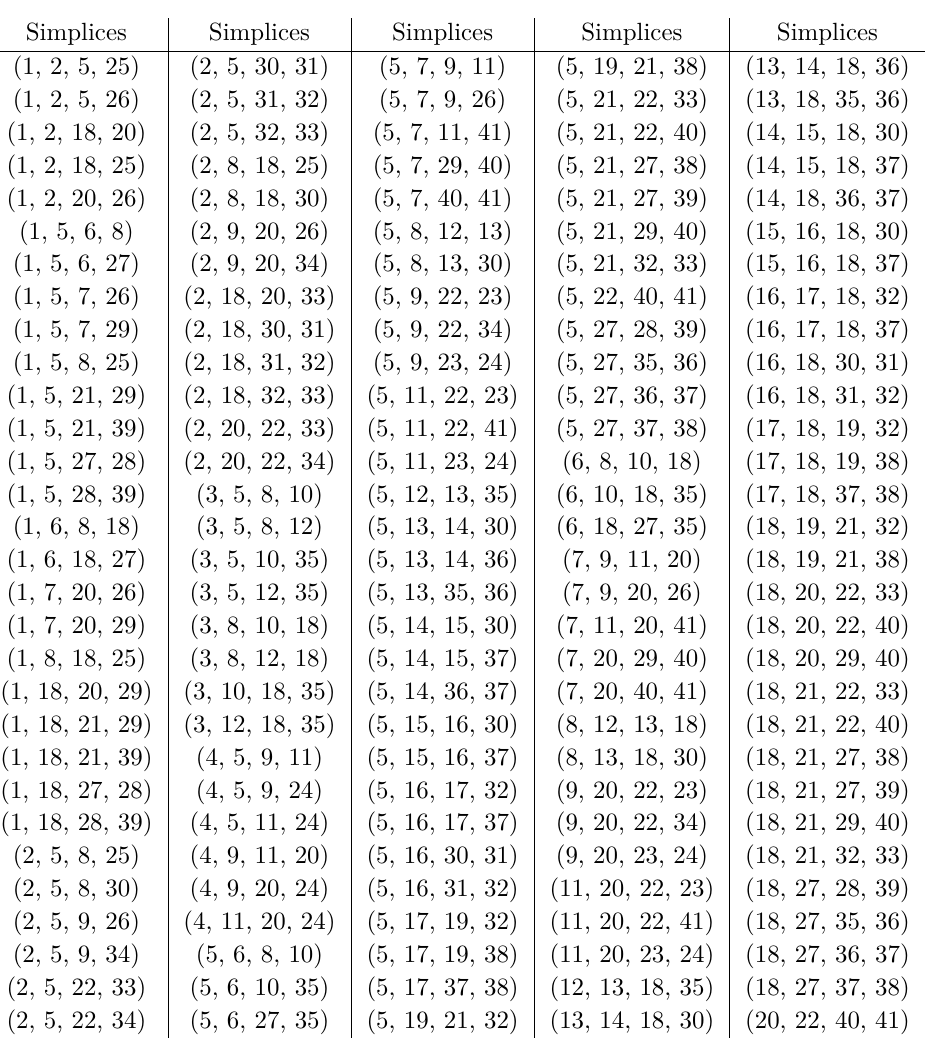
Table 2 . Simplices of the chosen FRST of ∆ . Each 4D cone of the FRST of ∆ is expanded by the rays ( v ) for the simplex ( i, j, k, l ) i , v j , v k , v l